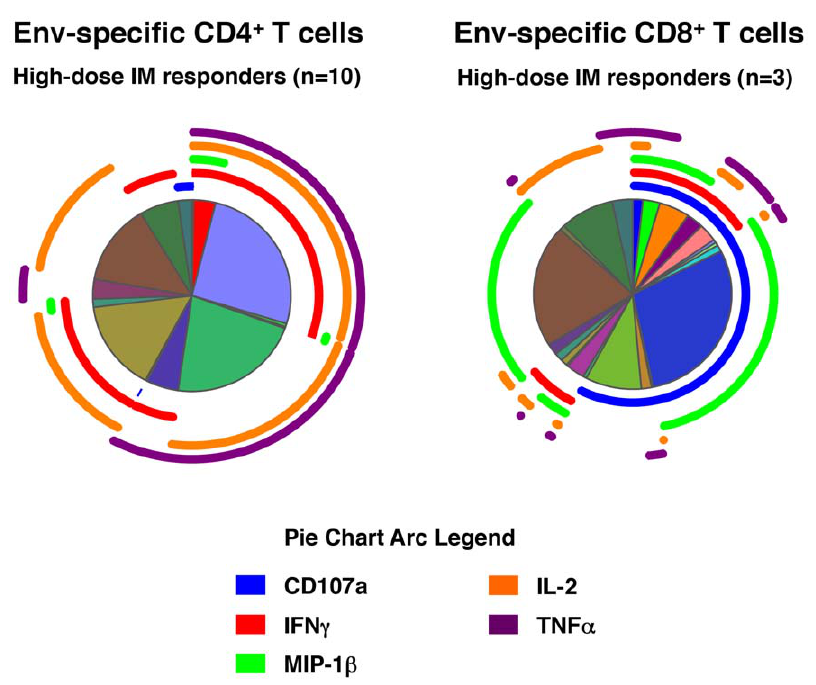
Figure 5. Multifunctional flow cytometry analysis for HIV Env-specific T cells. Analysis was based on the cumulative positive cells in all Boolean subsets for all volunteers who were scored as positive by single cytokine analysis in the high-dose (10 8 pfu) intra-muscular vaccine recipients ( Table 5 ). The legend shows the Pie Chart arcs representing each cytokine (or function). Pie Chart wedges show the relative sizes of the subsets of cells expressing the combination of functions represented in the surrounding Pie chart arcs. doi:10.1371/journal.pone.0013983.g005 PLoS ONE |